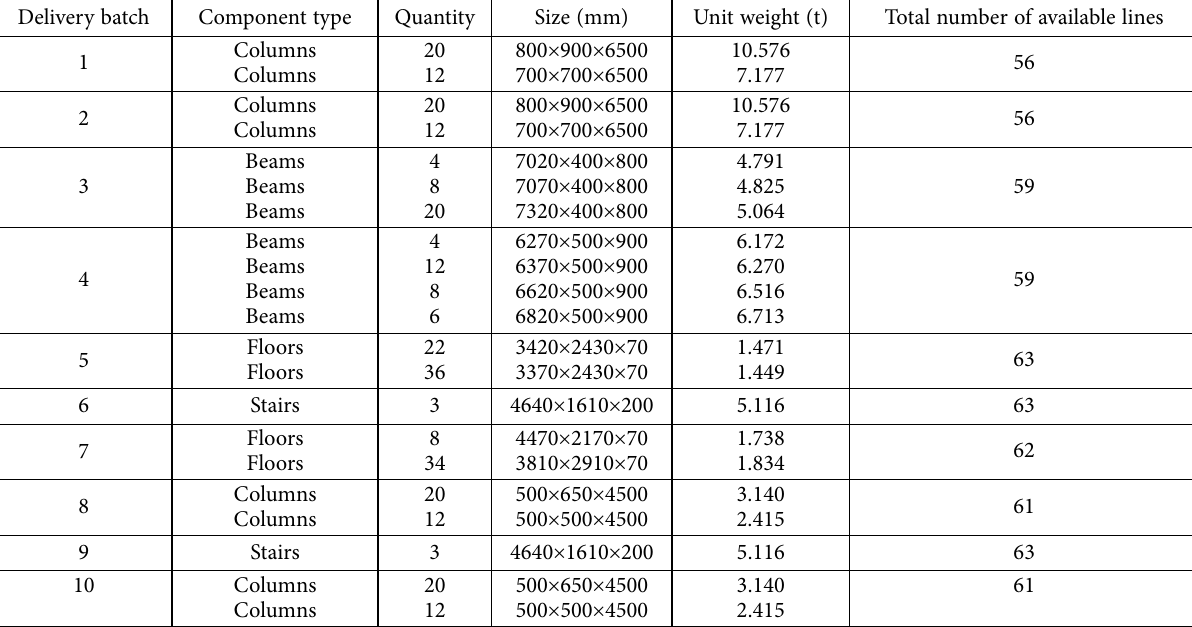
Table 3. Available transportation lines for the 10 delivery